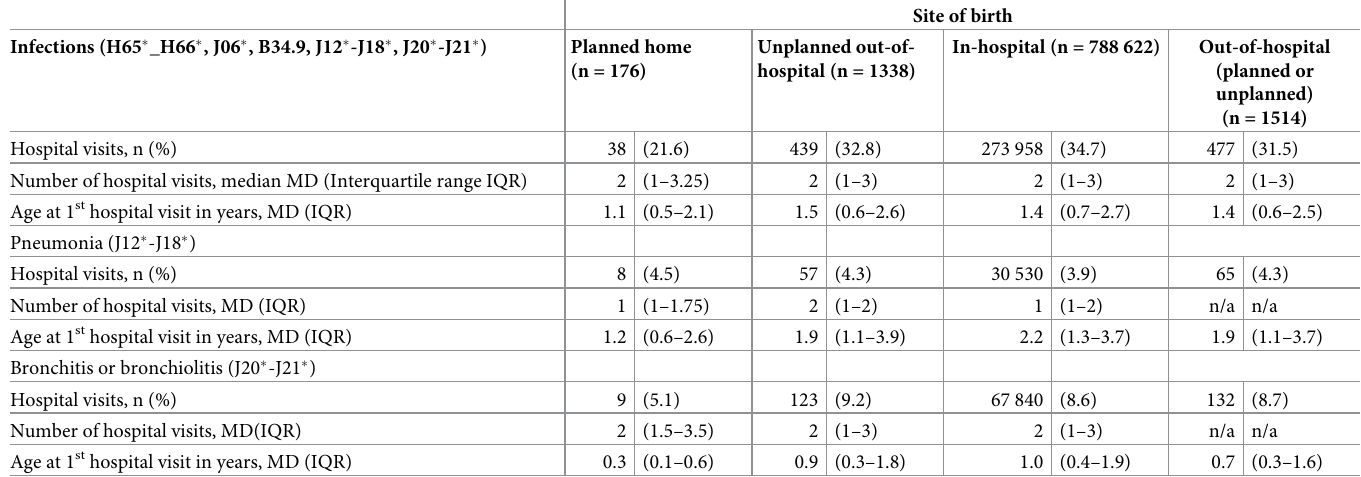
Table 4. Morbidity related to infections (n = 790 316).